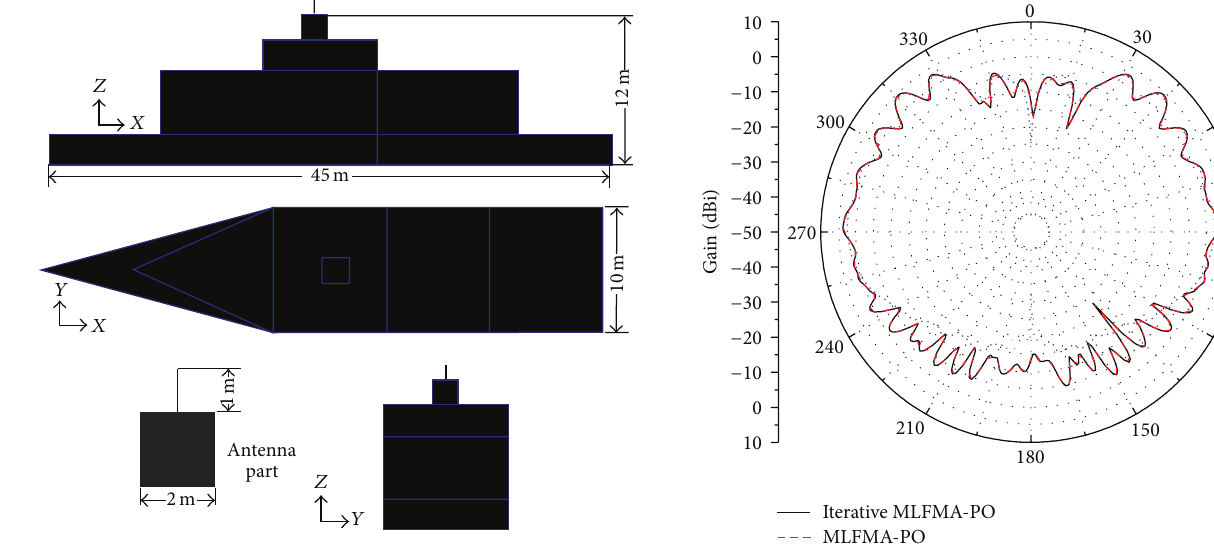
Figure 4: Wire antenna mounted on a ship model.